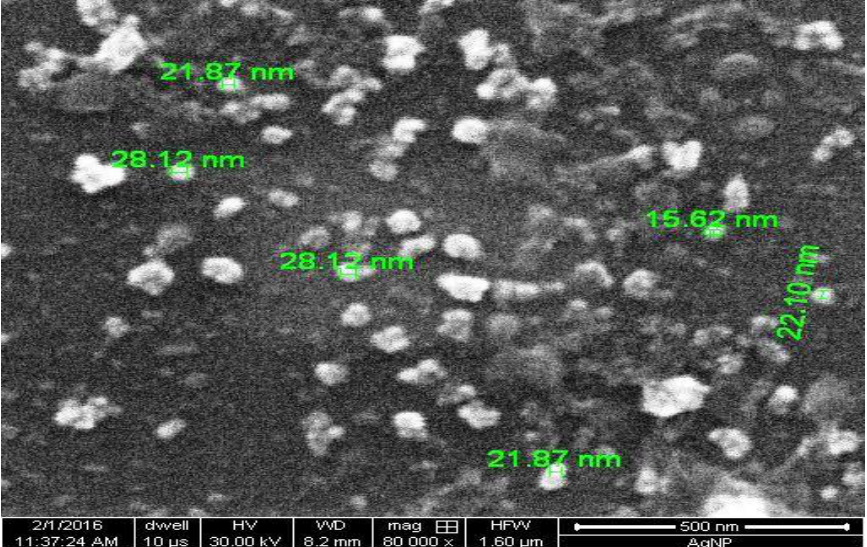
Fig. 4. The image represents the spherical shape of silver nanoparticles Figure 4: The image represents the spherical shape of silver nanoparticles